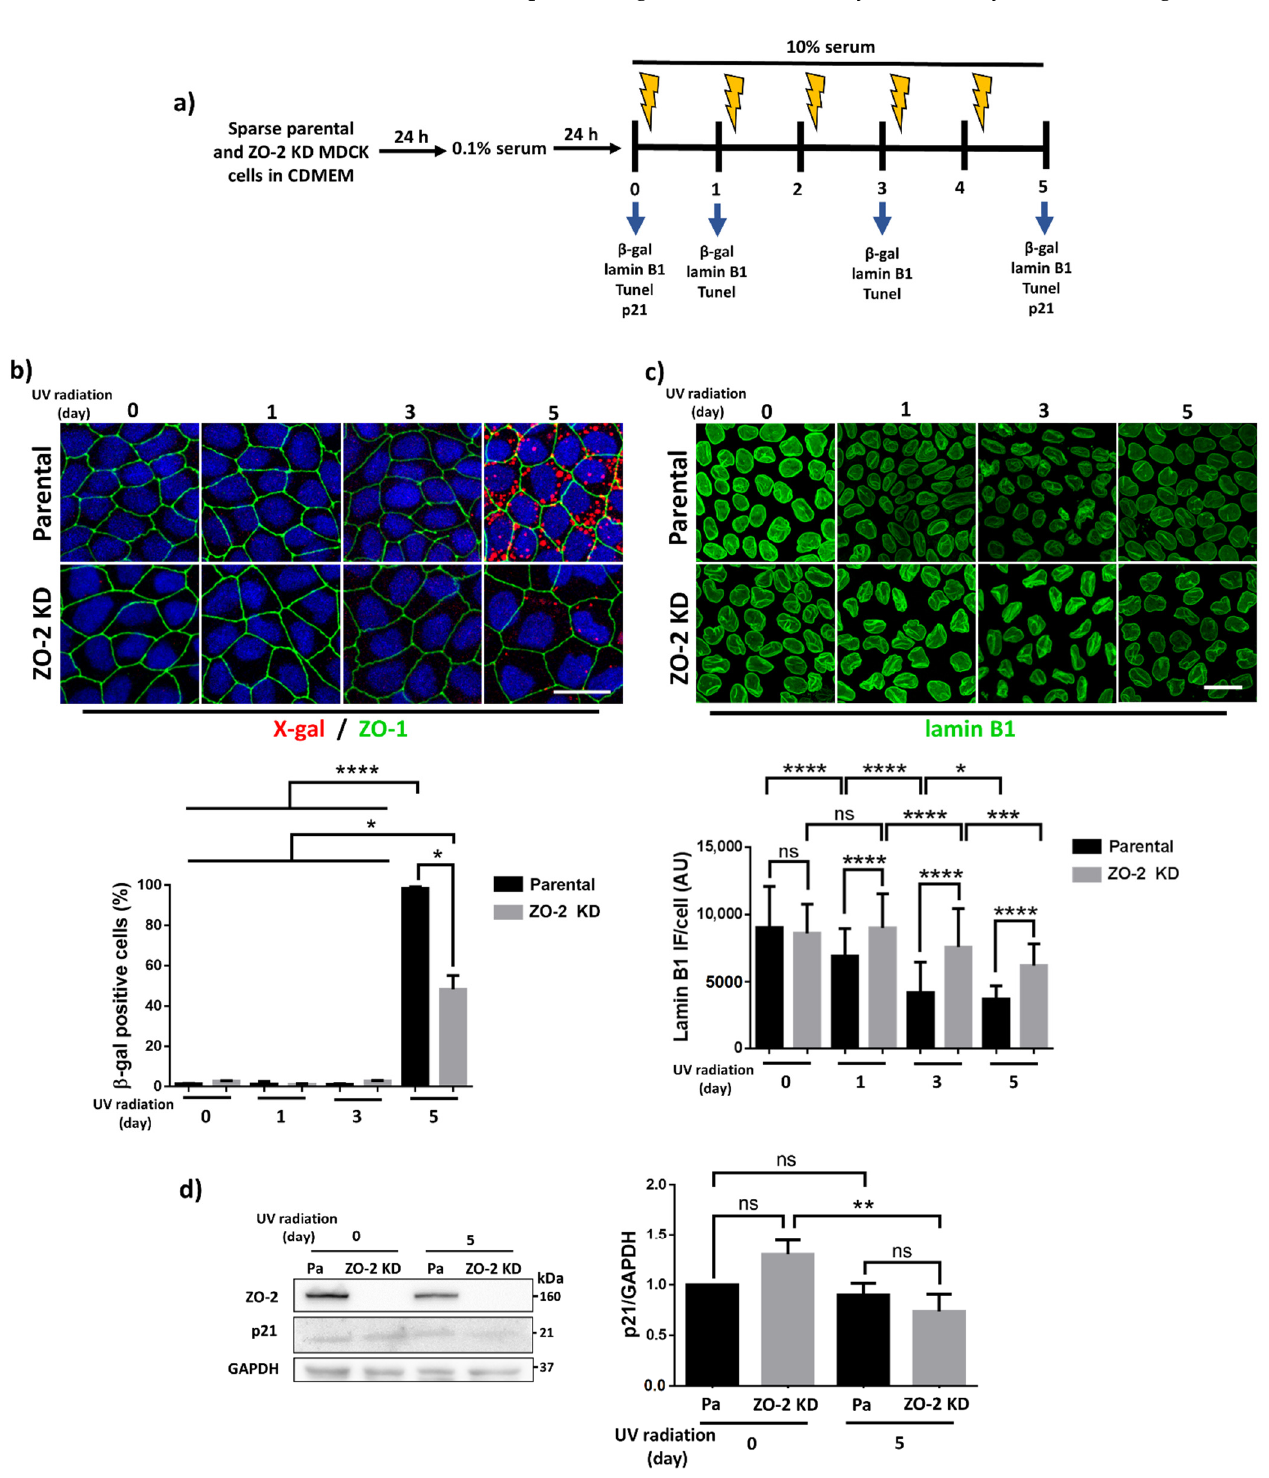
Figure 3. UV radiation-induced senescence is lower in ZO-2 KD cells than in parental cells. ( a ) Schematic representation of the UV-C irradiation treatment applied to parental and ZO-2 KD MDCK cells. Sparse cultures of parental and ZO-2 KD cells were incubated in CDMEM for 24 h and then transferred for one more day in media with 0.1% fetal calf serum. After that, the monolayers were transferred to media with 10% serum and irradiated for 2 sec with UV-C light (2 J/m 2 ) every day for 5 consecutive days. Monolayers were retrieved for immunofluorescence detection of β -galactosidase ( β -gal) or lamin B1 at days 0, 1, 3, and 5. ( b ) The activity of β -gal is lower in ZO-2 KD cells than in parental cells. The activity of β - gal was evaluated through its substrate X-gal that produces a dark blue precipitate that can be excited at 633 nm and emits fluorescence at 650–770 nm range. Monolayers were also treated with antibodies against ZO-1 to detect the cell borders, and the nuclei were stained with DAPI. Upper panel, representative images, bar, 20 μ m; lower panel, quantitative analysis done with ImageJ. Data obtained from three fields in each experimental condition. Statistical analysis was done with One- way ANOVA with Welch correction followed by Games–Howell’s comparisons test. Results are shown as media ± stand- ard deviation. * p < 0.05, **** p < 0.0001. ( c ) The decrease in lamin B1 expression triggered by UV radiation-induced senes- cence is delayed in ZO-2 KD cells. Lamin B1 immunofluorescence was detected with a specific antibody. Upper panel, representative images, bar, 20 μ m; lower panel, quantitative analysis done with ImageJ. Data obtained from at least 150 cells per condition derived from three fields in each experimental condition. Statistical analysis was done with Kruskal- Wallis followed by Dunn’s multiple comparisons test. Results are shown as media ± standard deviation. ns, non-signifi- cant, * p < 0.05, *** p = 0.001, **** p < 0.0001. ( d ) Western blot detection of p21 in parental and ZO-2 KD MDCK cells at 0 and 5 days after UV radiation. GAPDH was employed as a loading control. Left panel, representative Western blot; right panel, quantitative analysis of three independent experiments. Statistical analysis was done with one-way ANOVA followed by Tukey’s multiple comparisons test. Results are shown as media ± standard deviation, ** p < 0.01; ns, non-significant. 3.4. In ZO-2 KD MDCK Cells, the Expression of Lamins A/C and B, and Lamin B Receptor Is Unaffected Next, we studied the mechanism through which the lack of ZO-2 alters nuclear shape. Since changes in nuclear shape relate to an increase in the nuclear envelope’s flexibility [33], we analyzed the level of expression of lamins in ZO-2 KD cells. By immunofluores- cence and Western blot, we detected no changes in the level of expression of lamins A/C and B1 between parental and ZO-2 KD MDCK cells (Figure 4a,b). Nuclear lobulation can be accompanied by an increase in lamin B receptors [33]. However, by Western blot, we found no difference in the amount of the lamin B receptor present between the parental and ZO-2 KD cells (Figure 4c).